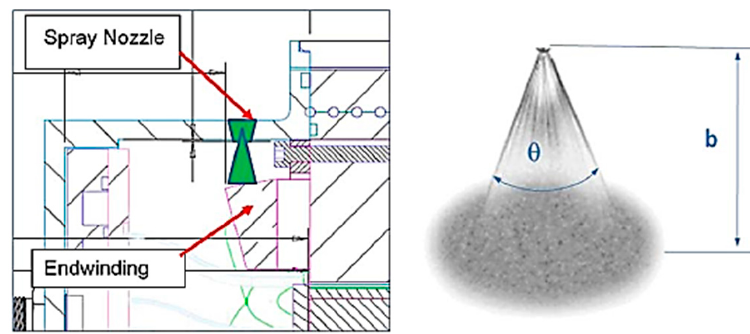
Figure 22. Oil spray-cooling at the end winding [68].